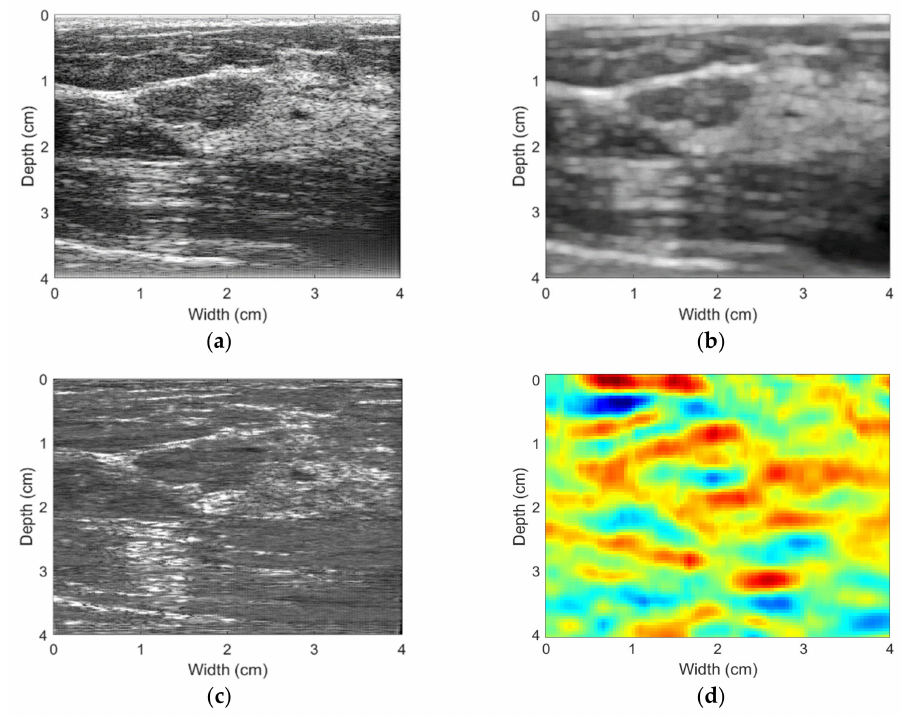
Figure 3. Sample images generated from the RF signals. ( a ) B-mode image; ( b ) Entropy image; ( c ) Phase image; ( d ) Attenuation